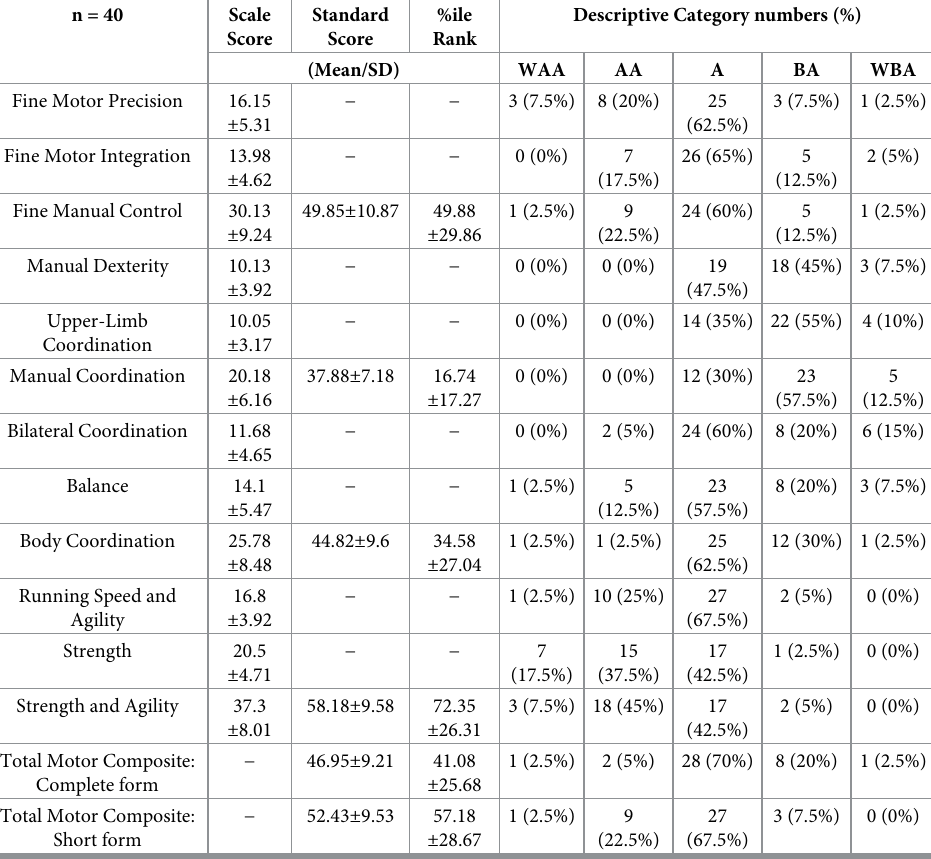
Total Motor Composite: − Complete form Total Motor Composite: Short form WAA: Well-Above Average (Scale Score � 25; Standard Score � 70; %ile Rank � 98); AA: Above Average (24 � Scale Score � 20; 69 � Standard Score � 60; 97 � %ile Rank � 84); A: Average (19 � Scale Score � 11; 59 � Standard Score � 41; 83 � %ile Rank � 18); BA: Below Average (10 � Scale Score � 6; 40 � Standard Score � 31; 17 � %ile Rank � 3); WBA: Well-Below Average (Scale Score � 5; Standard Score � 30; %ile Rank �